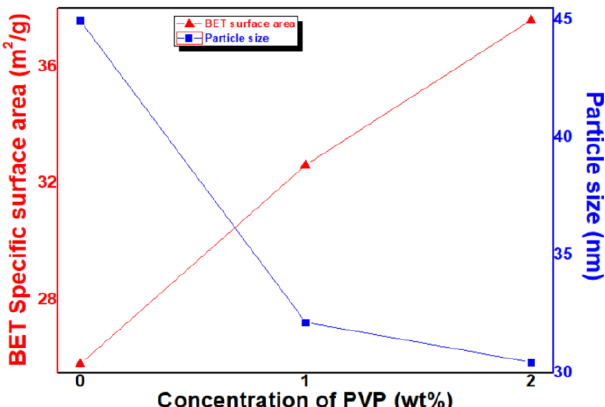
Figure 5. Variation of Brunauer, Emmett, and Teller (BET) specific surface area (SSA) and particle size (calculated by using Equation (2)) of FeO x NPs with a concentration of PVP.